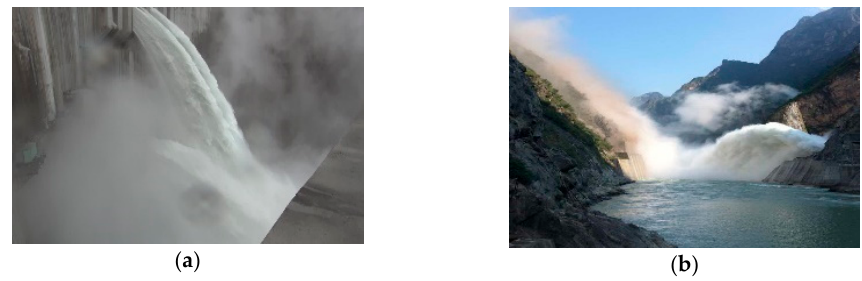
Figure 1. Prototype observation of flood discharge atomization in Jinping-1 Hydropower Station. ( a ) Flood discharge atomization induced by the release from dam orifices; ( b ) Flood discharge atomization induced by the release from a spillway tunnel.